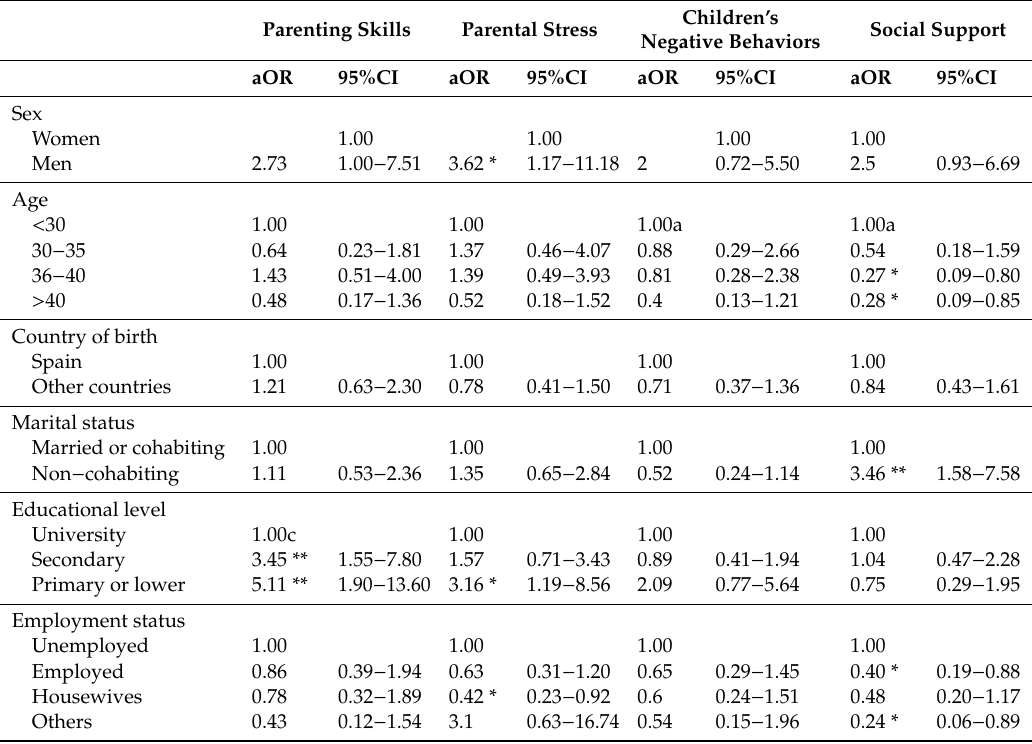
Table 3. Multivariate analysis of association between parents’ social factors and outcomes related to Parenting Skills Program for families (PSP). Adjusted Odds Ratios (aOR) and 95% Confidence Intervals